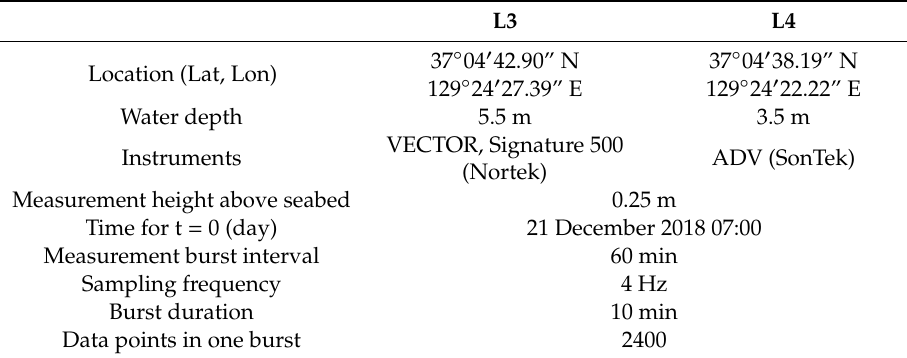
Table 2. Specification of measurements ate L3 and L4 during